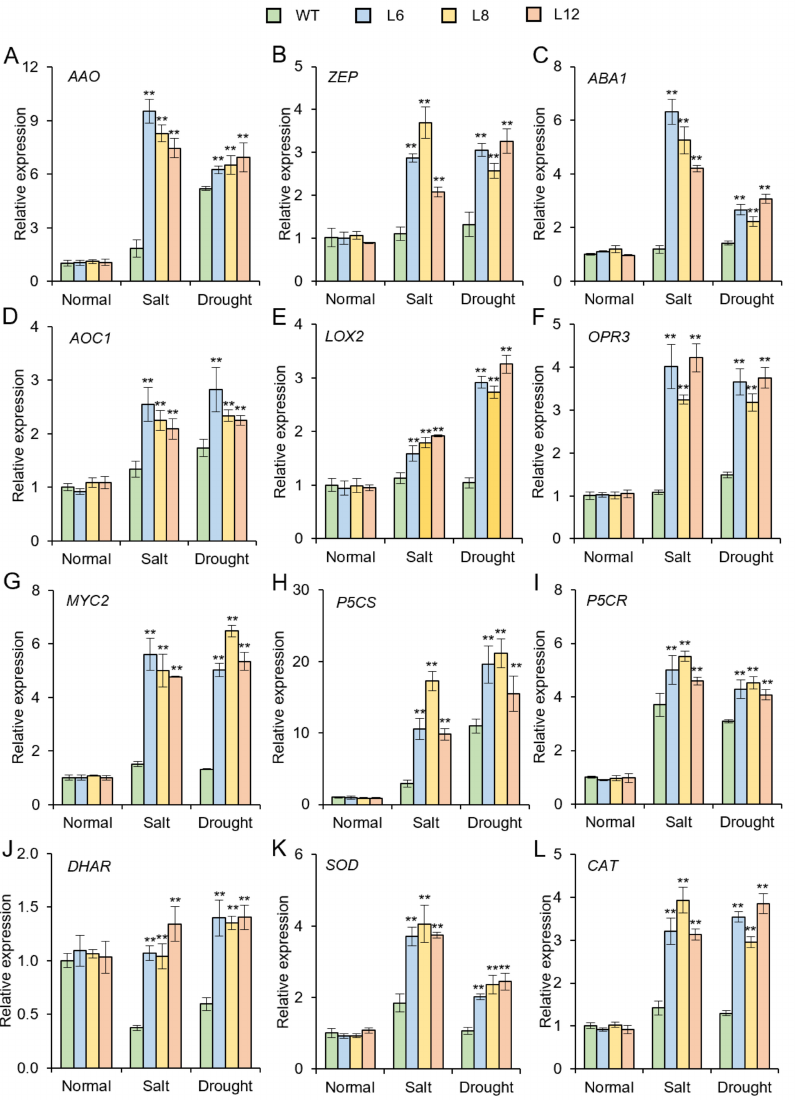
Figure 8. The expression profile of stress-related genes in transgenic lines and WT under salt and drought treatments for 2 weeks. The aerial parts of transgenic and WT plants were collected to extract total RNA. qRT-PCR analysis of the expression of ABA biosynthetic genes ( A – C ), JA biosynthesis and signaling pathway genes ( D – G ), proline biosynthetic genes ( H , I ) and ROS-scavenging genes ( J – L ). Values are indicated as means ± SE ( n = 3); Asterisk (**) indicates that there is a significant difference at p < 0.01, individually. AAO , ABA-aldehyde oxidase; ZEP , zeaxanthin epoxidase; ABA1 , ABA-deficient 1; AOC1 , allene oxide cyclase 1; LOX2 , 13-lipoxygenase 2; OPR3 ,